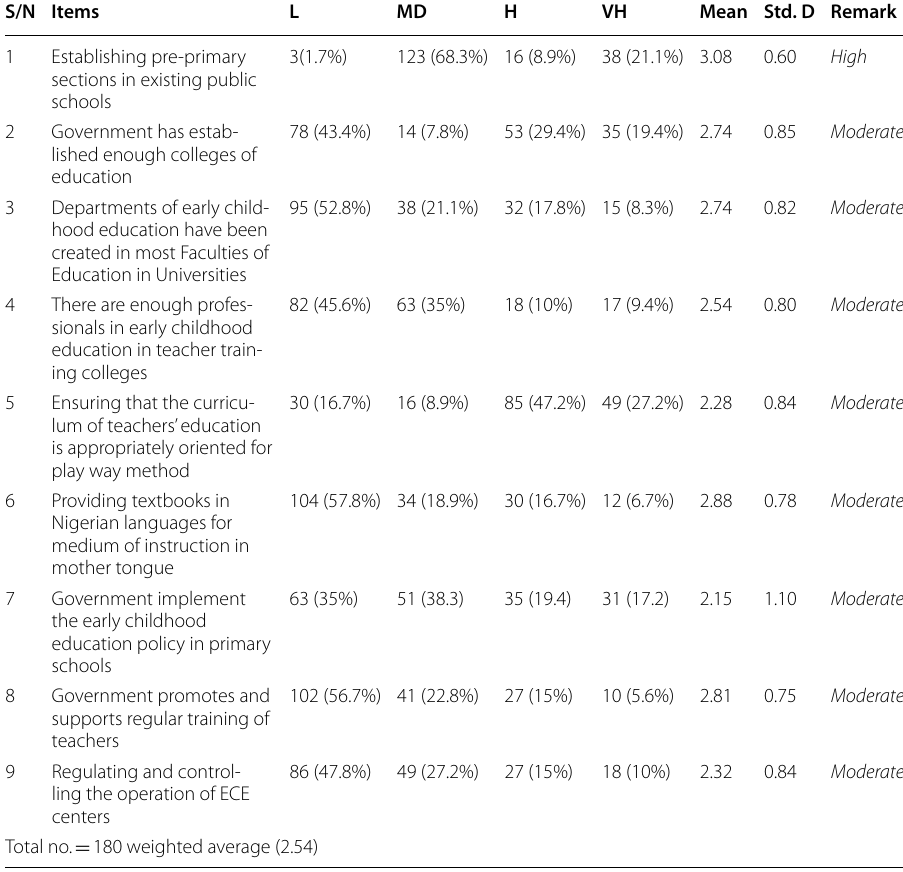
Table 1 Government commitments in fulfilling its obligations in ensuring effective quality